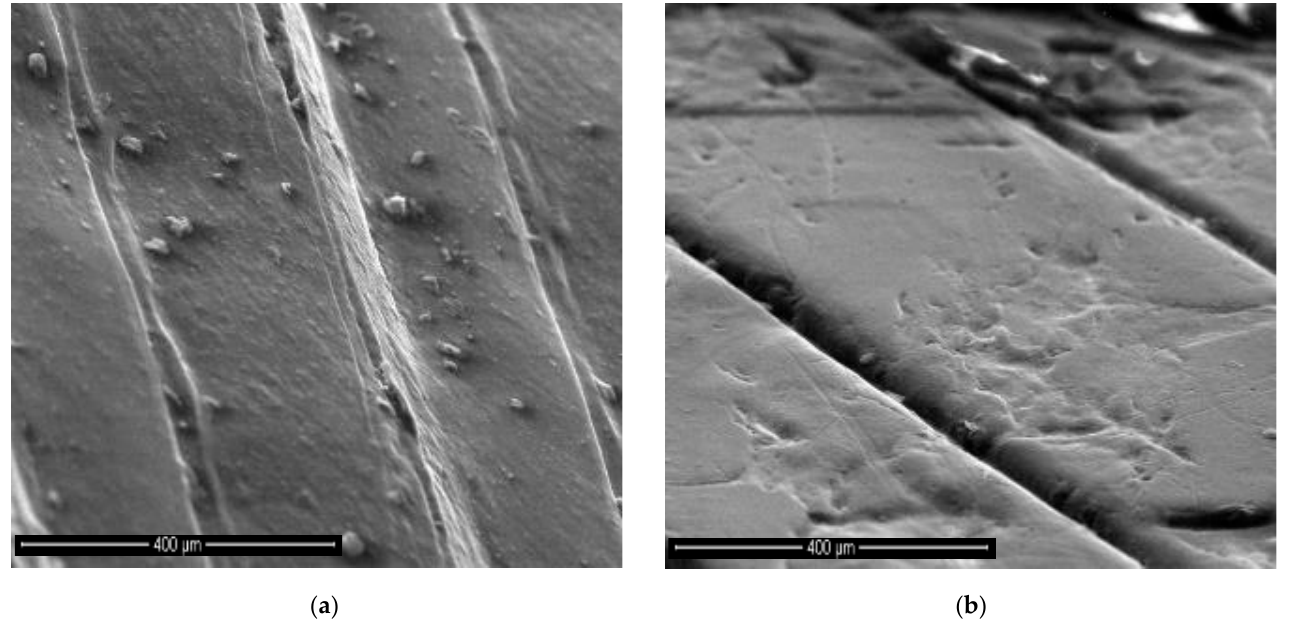
Figure 9. SEM image of ( a ) a control sample (that was not in contact with the biogas) versus ( b ) a middle sample—to highlight the level of degradation due to biogas exposure.